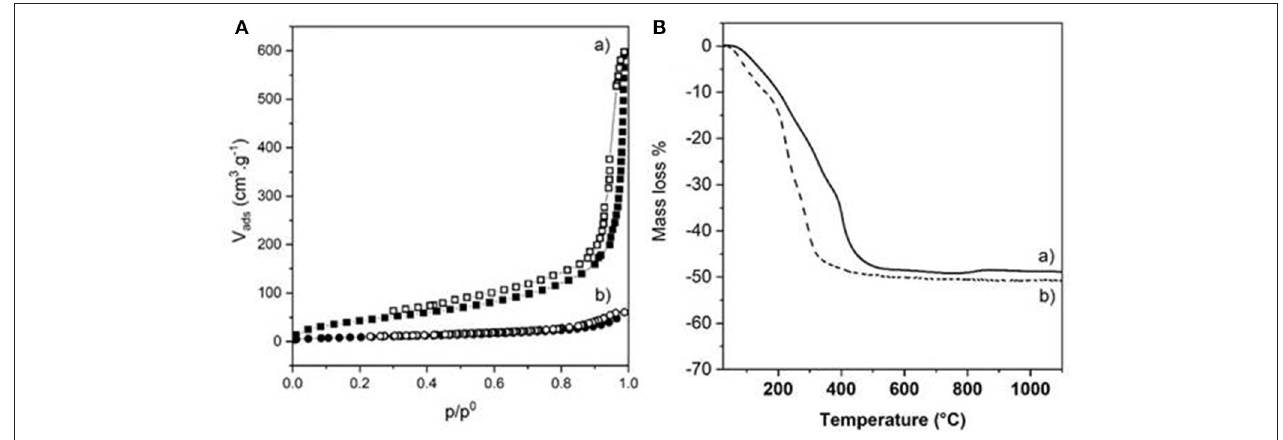
FIGURE 6 | (A) N 2 adsorption-desorption isotherms and (B) TGA curves of (a) NiAl@Alg-Ca beads and (b) NiAl@Alg beads dried upon CO 2 supercritical conditions.